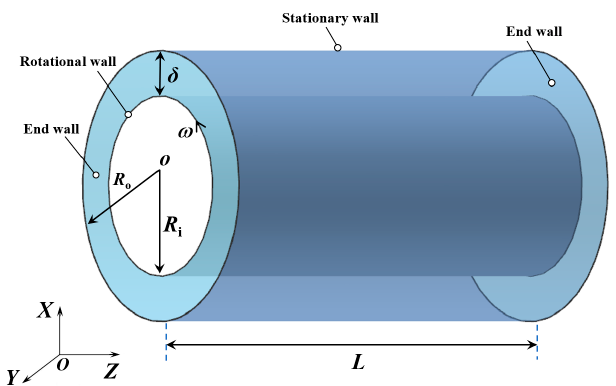
Figure 2. Schematic diagram of computational domain composed of two end walls, a rotational wall and a fixed wall.